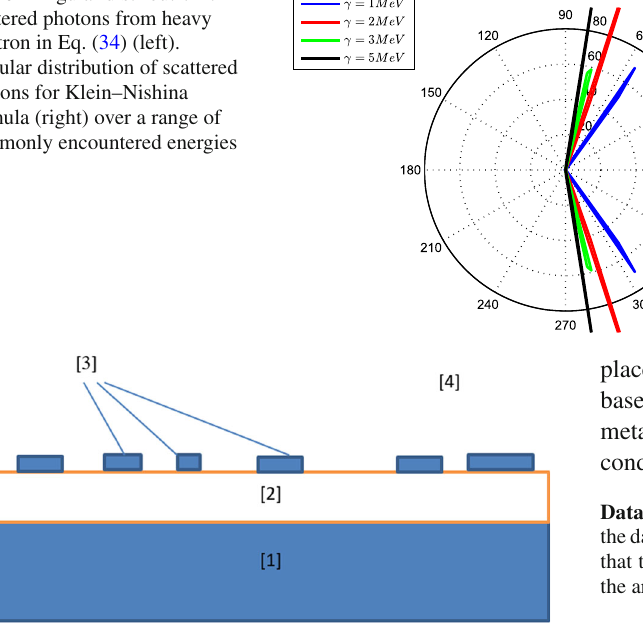
Fig. 3 Angular distribution of scattered photons from heavy electron in Eq. (34) (left). Angular distribution of scattered photons for Klein–Nishina